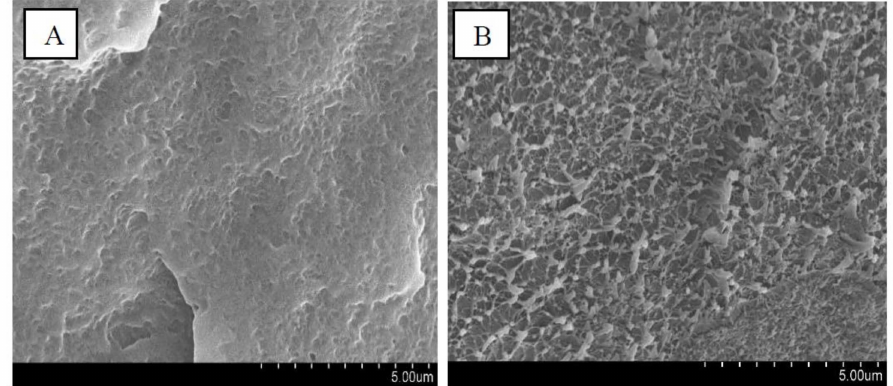
Figure 1. Scanning electron microscopy (SEM) micrographs of cryofractured surfaces of: ( A ) HDPE and ( B ) HDPE-1% nanocomposite elaborated with cyclohexane assisted extrusion process.